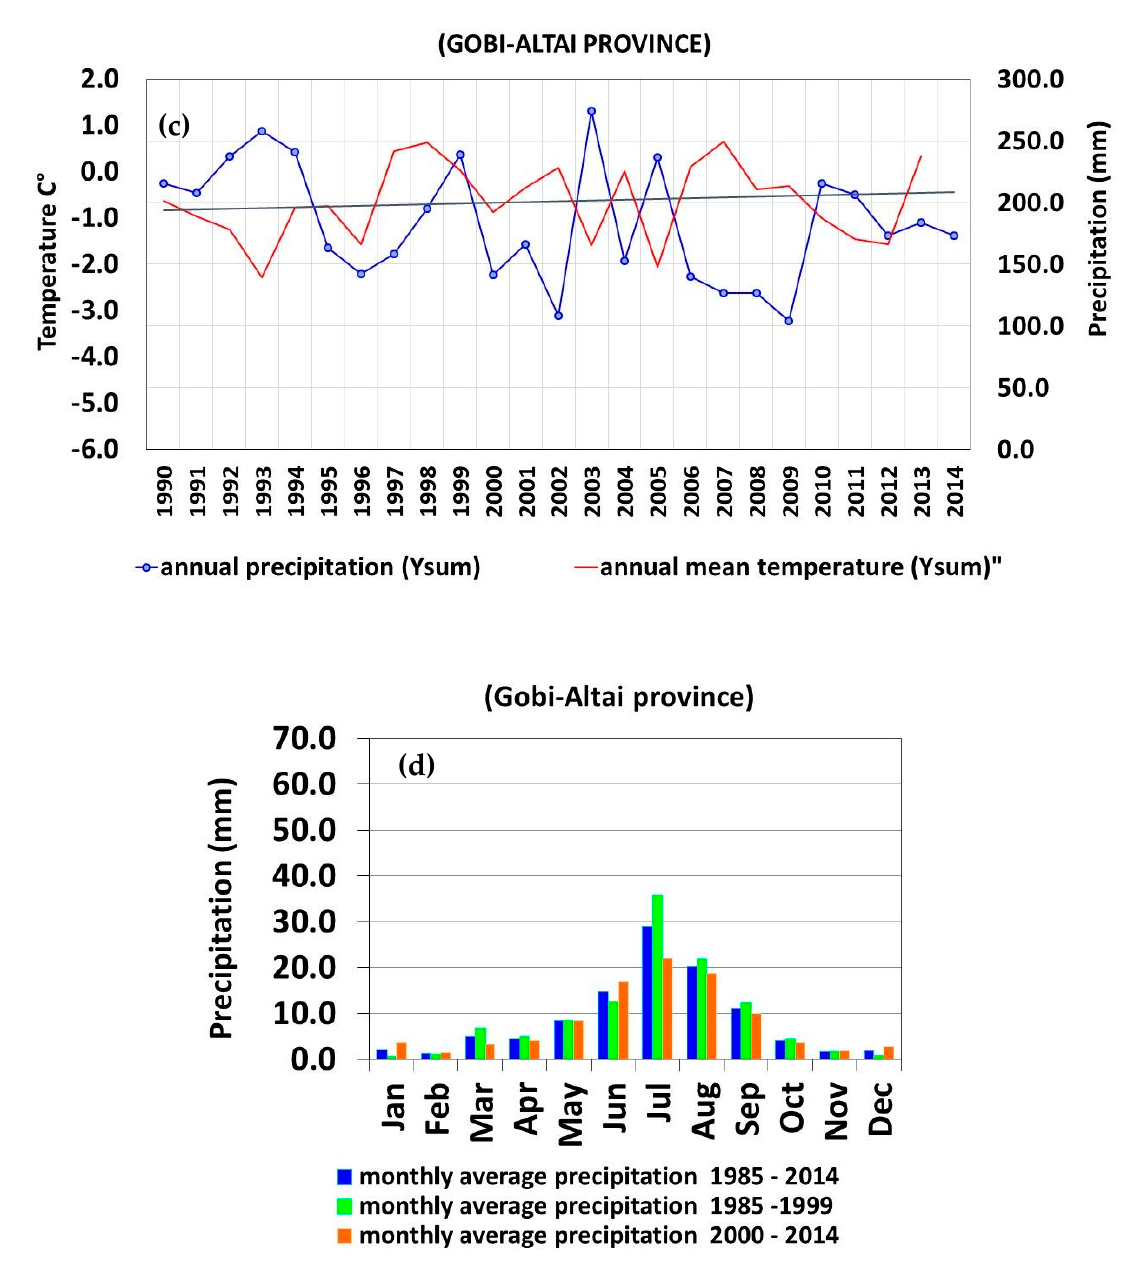
Figure 9. Comparison between mean annual precipitation and mean monthly precipitation ( a , b ) from 1985 to 2014 in Bayankhongor province and ( c , d ) from 1990 to 2014 in Gobi-Altai province.